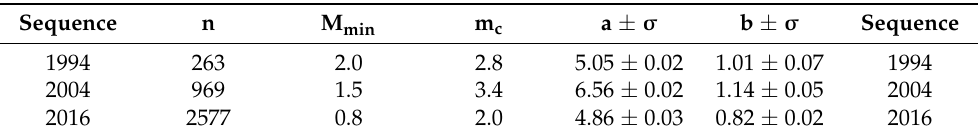
Figure 3. Temporal evolution of the studied series (magnitudes above 2.0). Starting of the x-axis does not always correspond to the occurrence of the main event. Table 1. Number of events (n), minimum recorded magnitude (M min ), computed threshold magni- tude (m c ) using the Maxc method and a and